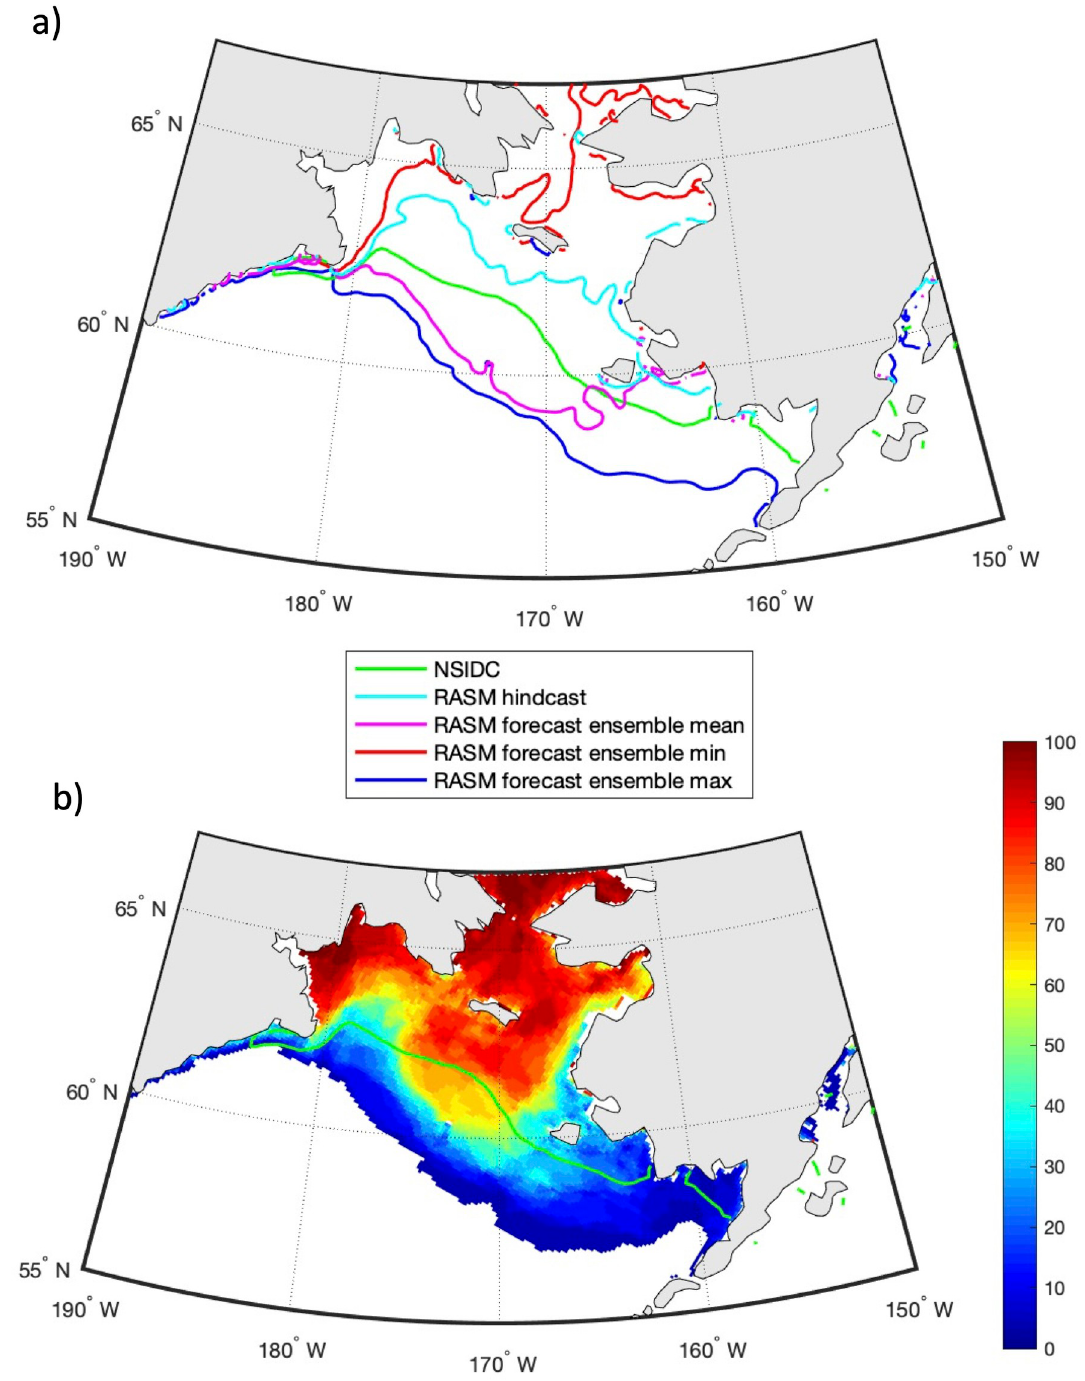
Fig 13. Predictions of sea ice extent and probability for April 15, 2020. (a) The RASM predicted ensemble mean (purple), maximum (blue) and minimum (red) sea ice extent on April 15, 2020, with all 31 individual member forecasts initialized on February 1, 2020. (b) The predicted probability of sea ice extent for April 15, 2020. The green line is the NSIDC observed sea ice extent [43] on April 15, 2020. The light blue line is the respective sea ice extent from the RASM hindcast. Figure created using Matlab (v. 2018a) from the authors’